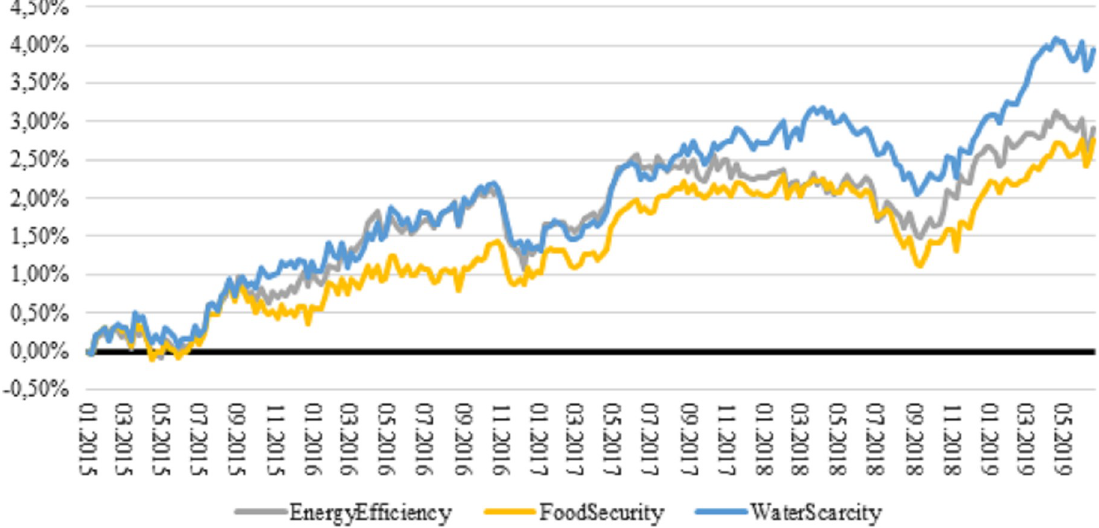
Fig 2. Cumulative market-relative return of environment megatrends, 2015–2019. Returns are total log returns. MXWD is the Bloomberg ticker for MSCI ACWI